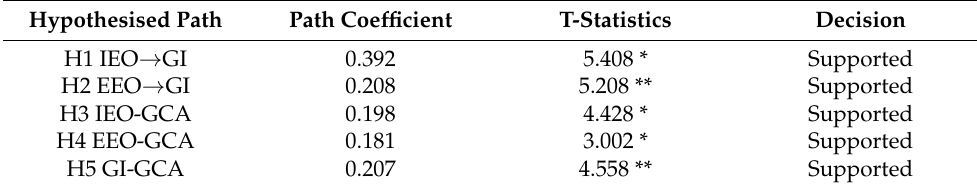
Table 4. Path coefficient and T-statistics.